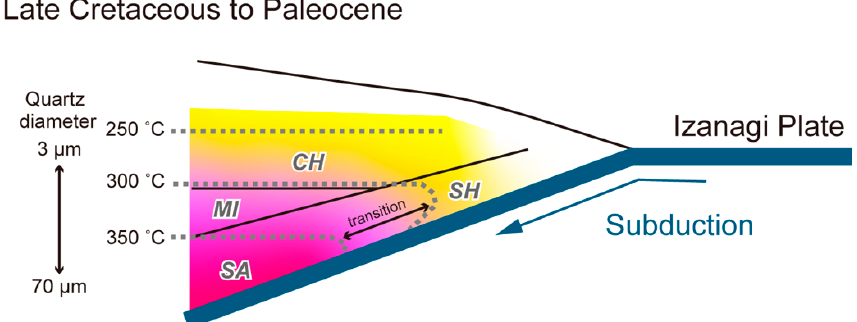
Figure 10. Tectonic model of the Late Cretaceous to Paleocene accretionary wedge, showing the RSCM temperature estimates and the range in quartz diameter. SA: Sanbagawa metamorphic complex; MI: Mikabu greenstones; CH: Chichibu accretionary complex; SH: Shimanto accretionary complex.